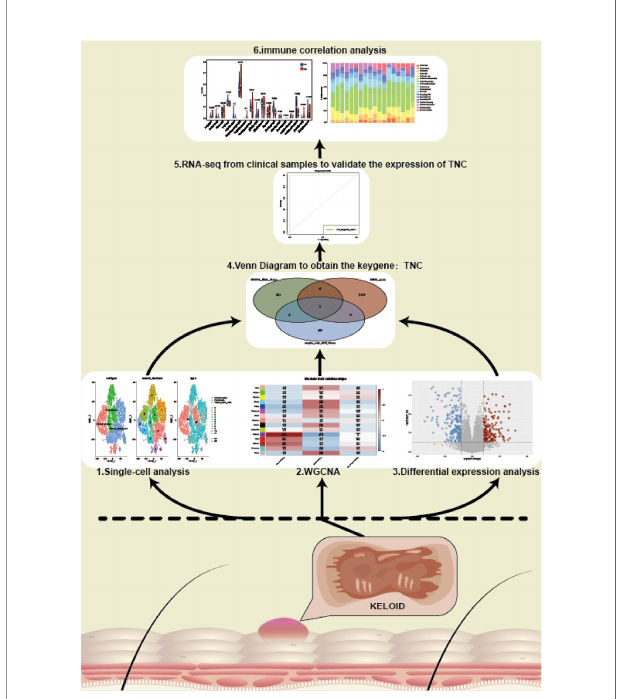
FIGURE 1 | The fl ow chart of our